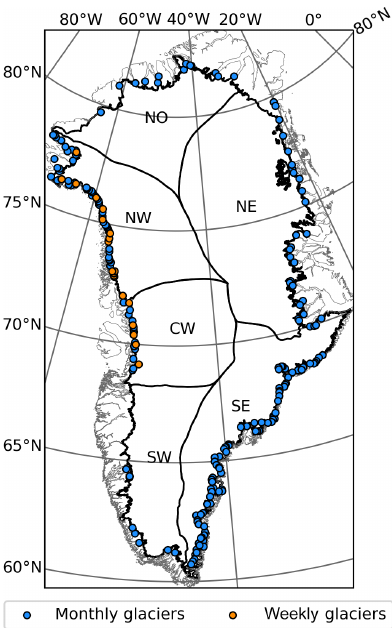
Figure 1. Map of glaciers covered in this study. Glaciers with ter- mini digitized at monthly resolution are in blue, and glaciers with termini digitized at 6d resolution are in orange. The regions out- lined are southwest (SW), central west (CW), northwest (NW), north (NO), northeast (NE), and southeast (SE)